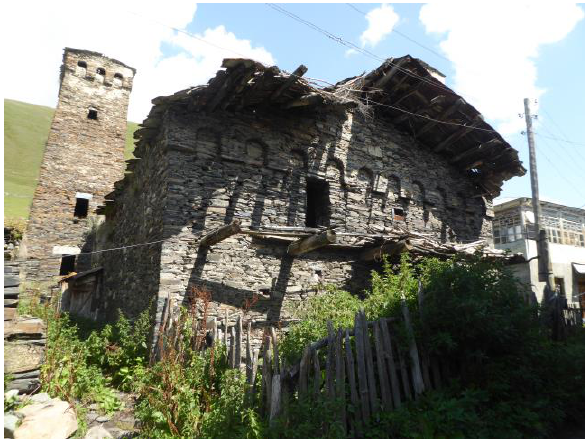
Figure 1. Domestic cluster with tower in Murkmeli, Upper Svaneti, CI-ESG, 2018.